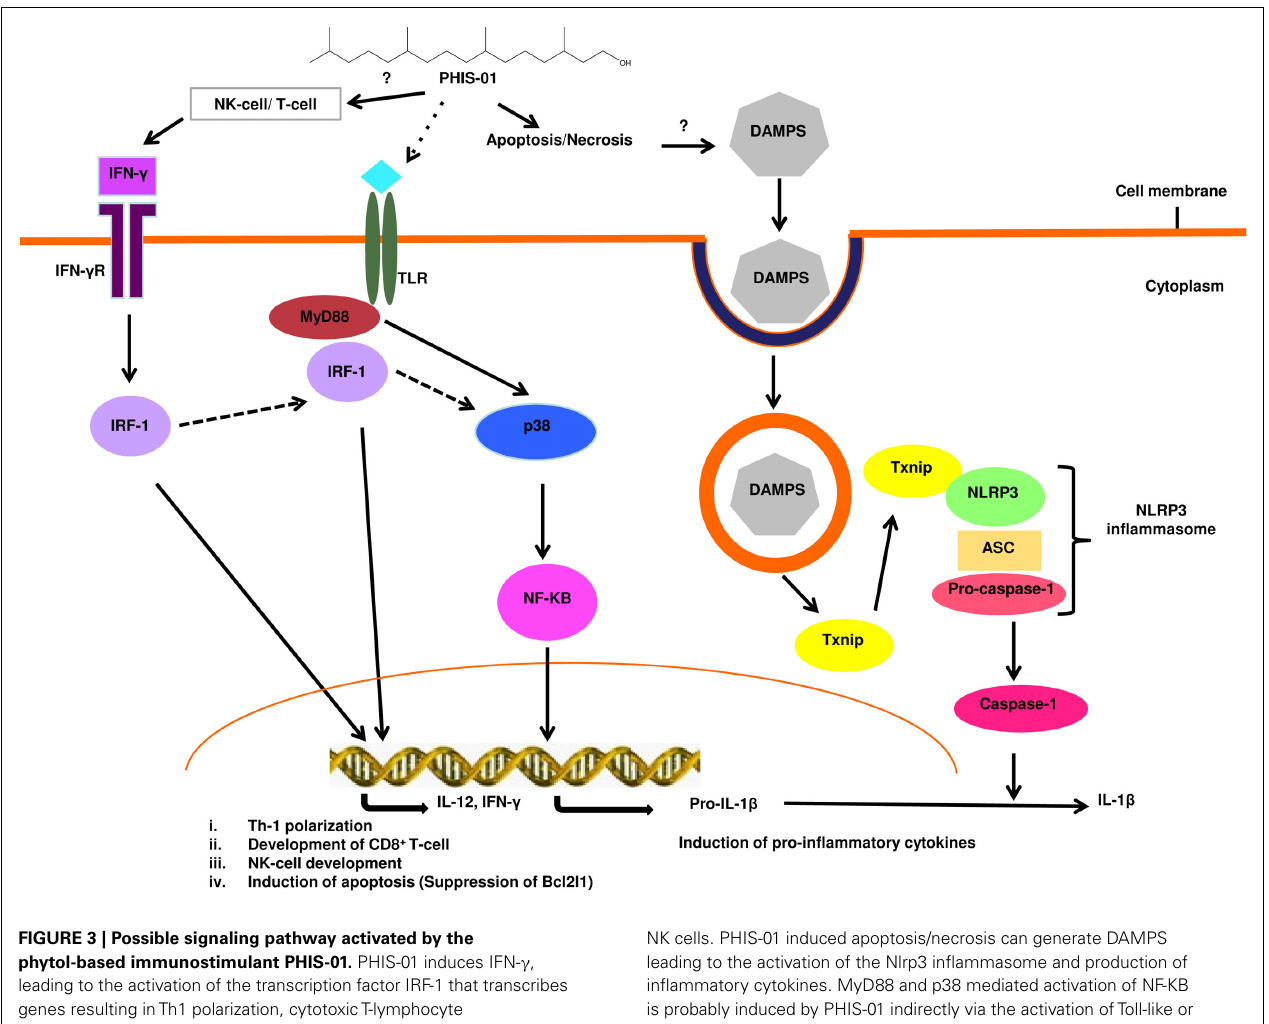
FIGURE 3 | Possible signaling pathway activated by the phytol-based immunostimulant PHIS-01. PHIS-01 induces IFN- γ , leading to the activation of the transcription factor IRF-1 that transcribes genes resulting inTh1 polarization, cytotoxicT-lymphocyte development, induction of apoptosis and also possibly the activation of